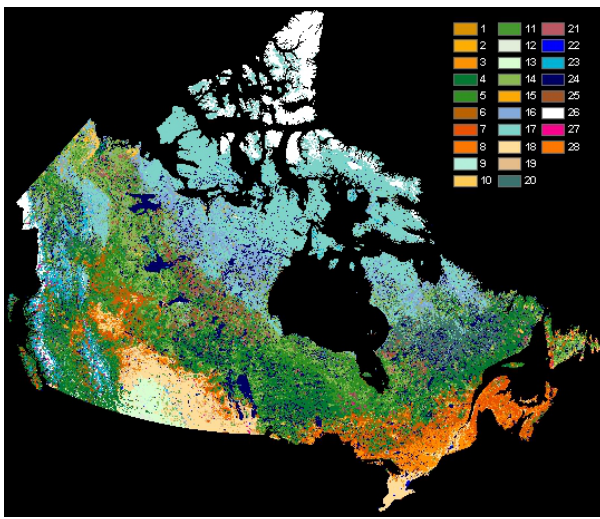
Fig. 3. Land cover of Canada’s landmass retrieved from the SPOT 4 VEGETATION data for year